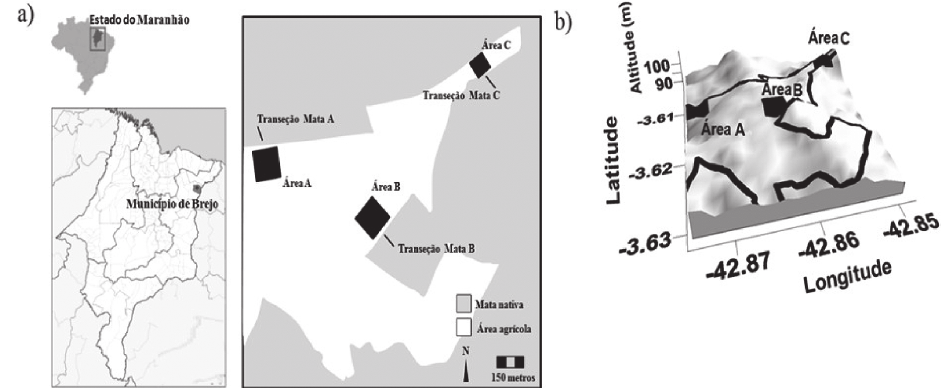
Figura 1. a) Localização da área de estudo; e b) Localização dos perfis dos solos estudados em três áreas, por meio do modelo digital de elevação